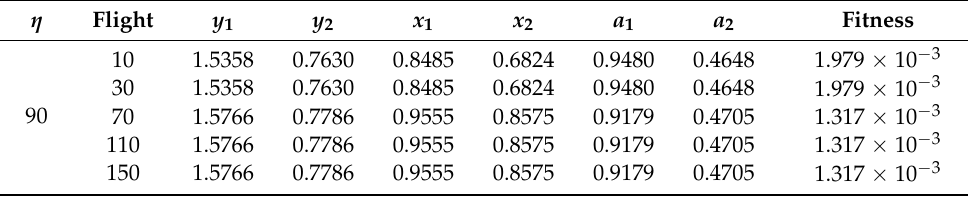
Table 3. Parameter estimates with the level of estimation accuracy for ε =